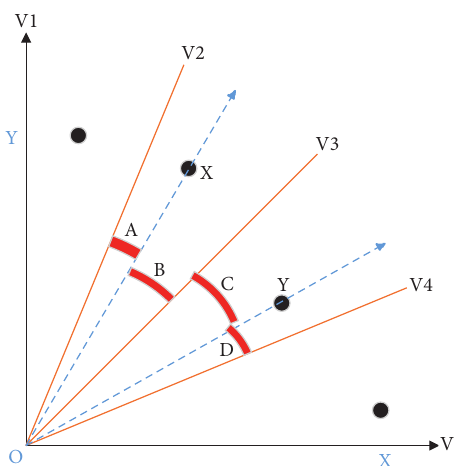
Figure 3: An example showing the definitions of